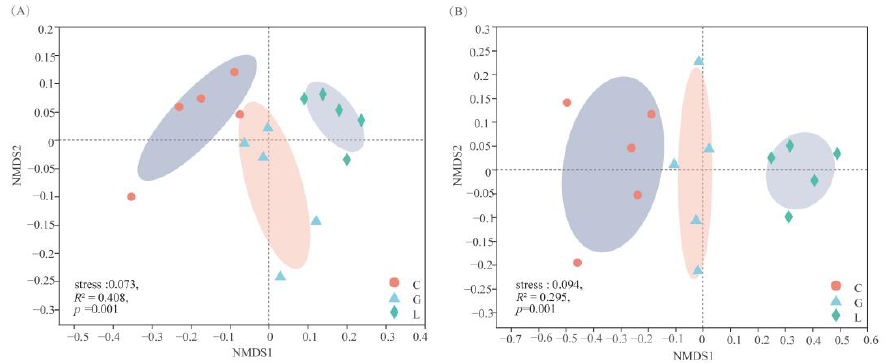
Figure 5. Community structure characteristics of soil bacteria ( A ) and fungi ( B ) under three planting coverts.